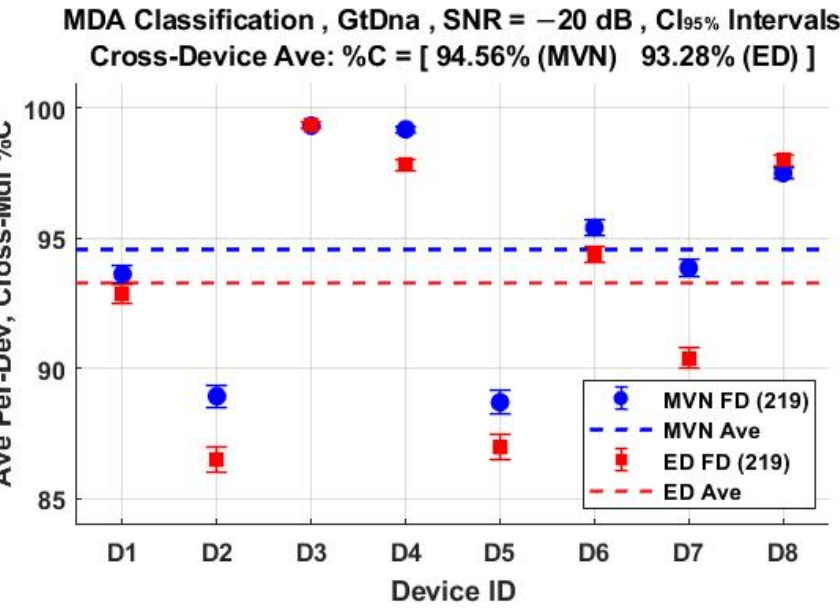
Figure 11. Per-device MDA classification performance for the N Mdl = 56 models in Table 2. Results are for the full-dimensional N FD-GT = 219 feature set generated under SNR = − 20 dB conditions using ED ( ■ ) and MVN ( ● ) measures of similarity.